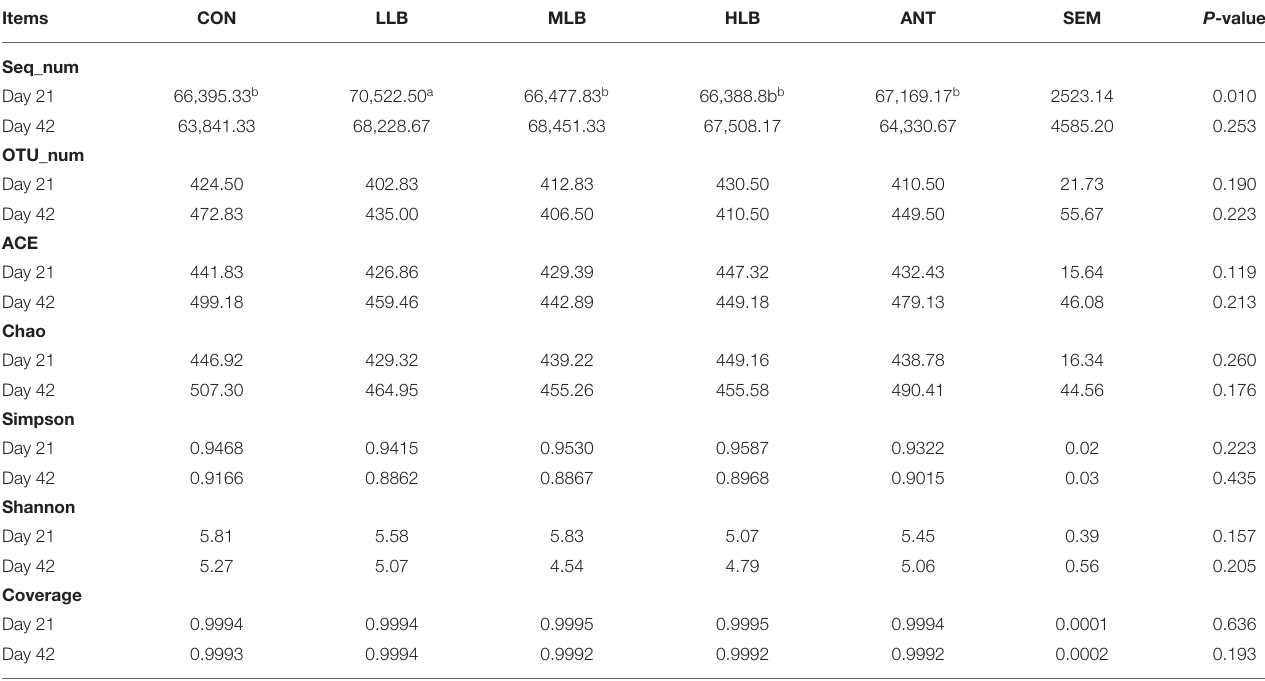
TABLE 3 | Sequencing data and the alpha diversity in each group of Pekin ducks 1 . Items